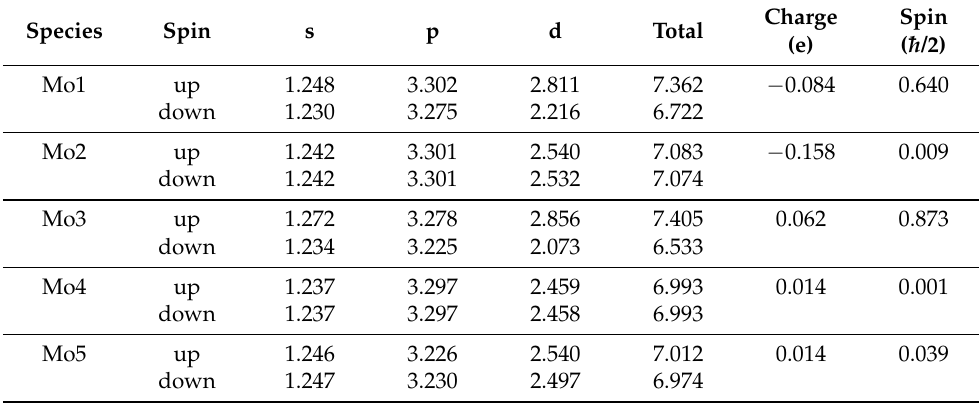
Table A2. Atomic populations (Mulliken) for mq-GOpt As 2 S 3 :Mo.